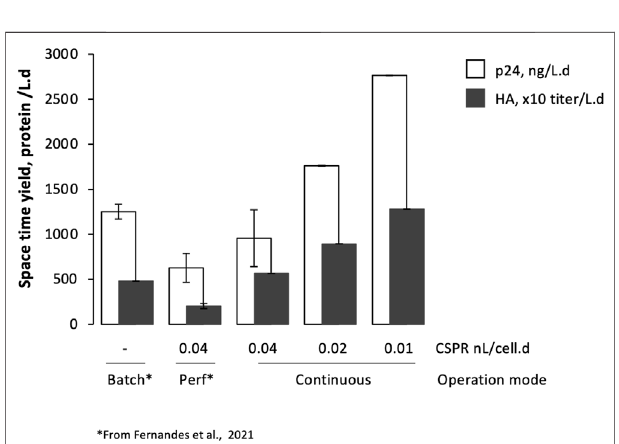
Frontiers in Bioengineering and Biotechnology |